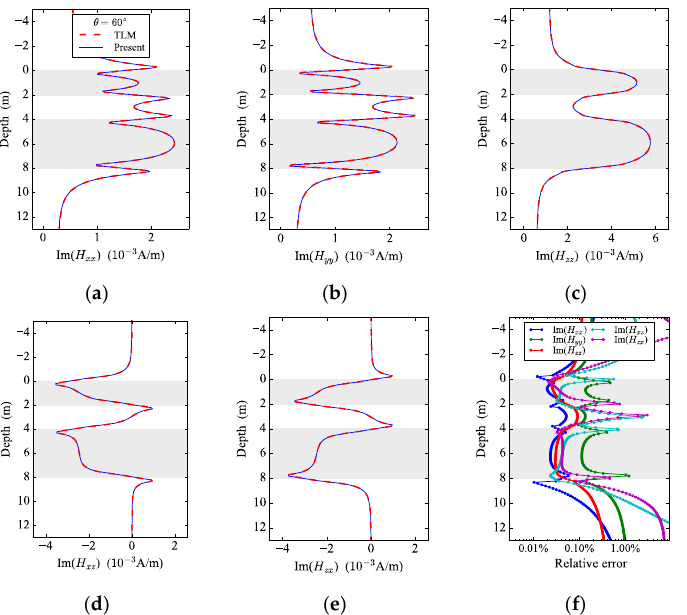
Figure 9. Responses of the tool with dip angle θ = 60 ◦ simulated by TLM and the present method. ( a ) Im( ) xx H . ( b ) Im( ) yy H . ( c ) Im( ) zz H . ( d ) Im( ) xz H . ( e ) Im( ) zx H . ( f ). Relative error.